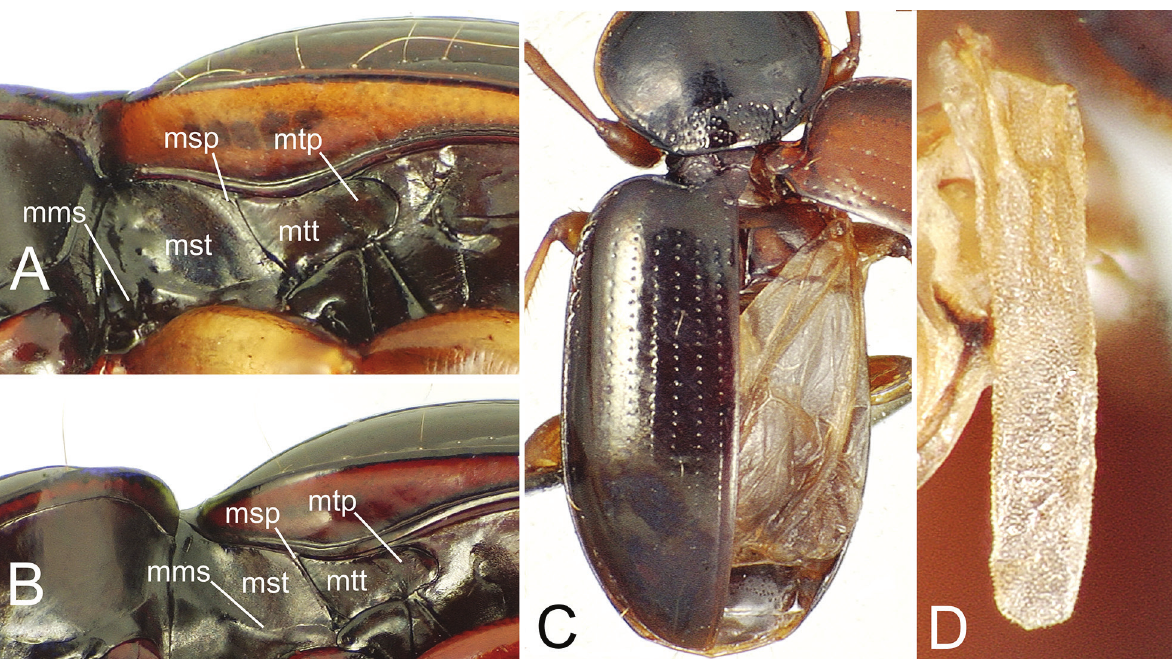
Figure 3. Thoracic structures of Mecyclothorax spp. A–B . Lateral view of elytral epipleuron and meso-and metapleurites: A , M. laterorectus ; B , M. fleutiauxi . C–D . Metathoracic flight wing: C , M. punctipennis , showing fully developed flight wing folded under elytron; D , M. lissus , stenopterous wing rudiment that extends beyond metanotum, rudimentary wing venation present at base of strap. Abbreviations include: mms , mesepisternal-mesosternal suture; msp , mesepimeron; mst , mesepisternum; mtp , metepimeron; mtt , metepisternum.